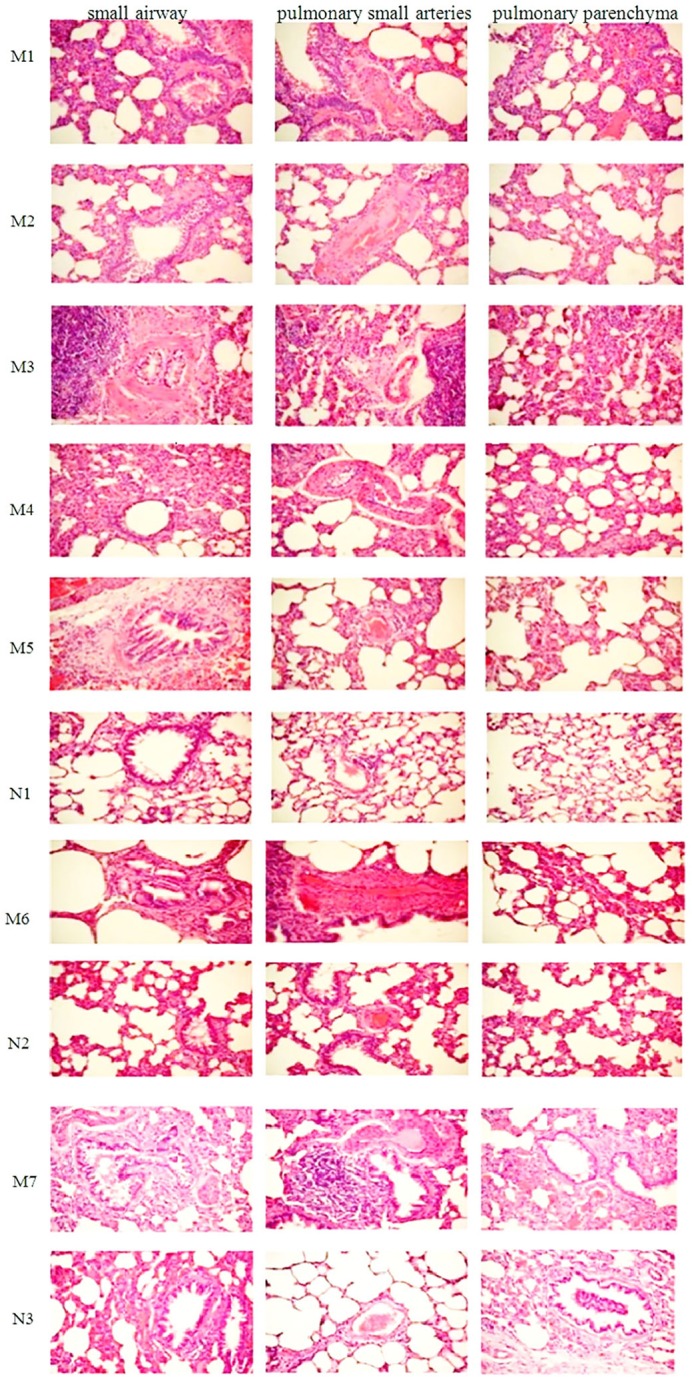
Photograph of HE-stained lung tissue under an optical microscope (×200). M1, 2-week cigarette smoke (CS) exposure group; M2, 4-week CS exposure group; M3, 8-week CS exposure group; M4, 12-week CS exposure group; M5, 8-week CS exposure + 4-week CS cessation group; M6, 24-week CS exposure group; M7, 36-week CS exposure group; N1, 12-week normal group; N2, 24-week normal group; N2, 36-week normal group. H&E, haematoxylin–eosin.